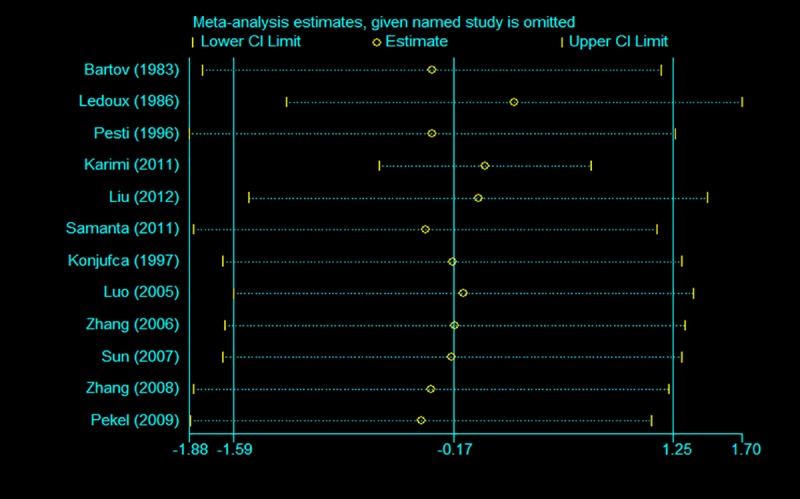
Sensitivity analysis of ADG.